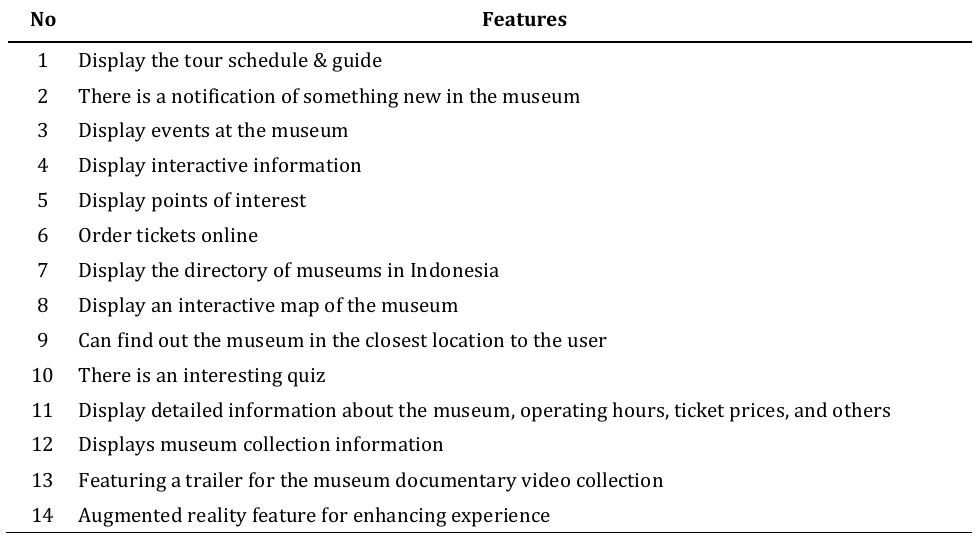
Table 3 Features Expected from Mobile Application of Museum from Questionary